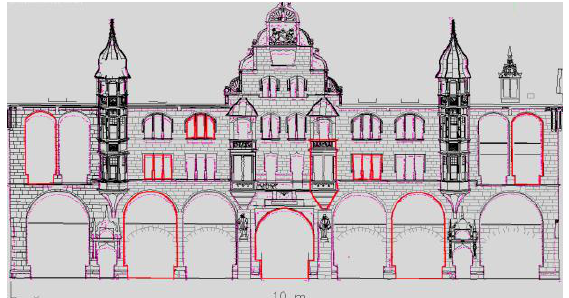
Figure 4. Restituted map (in black) with assessment contours (in red). Extracted contour points appear in magenta.